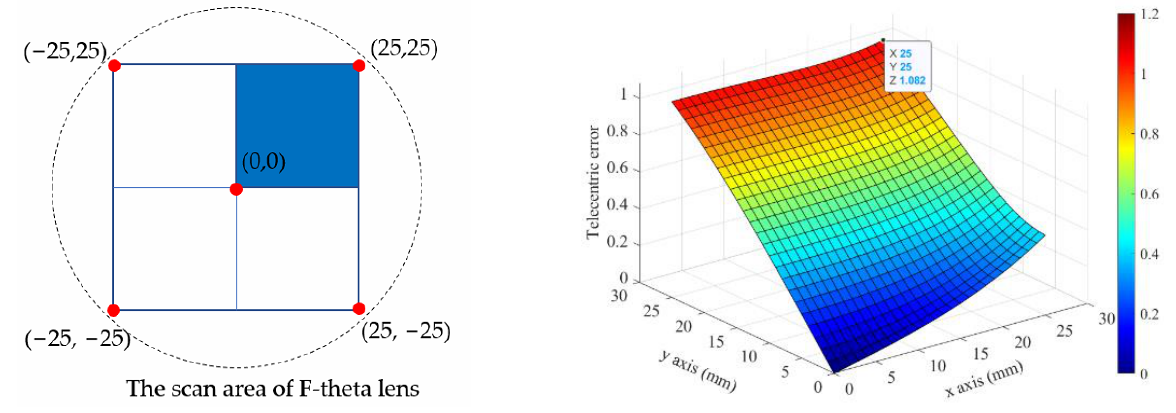
Figure 2. Telecentricities at different positions on the X and Y axis with a scan area of 25 × 25 mm 2 of the workpiece.